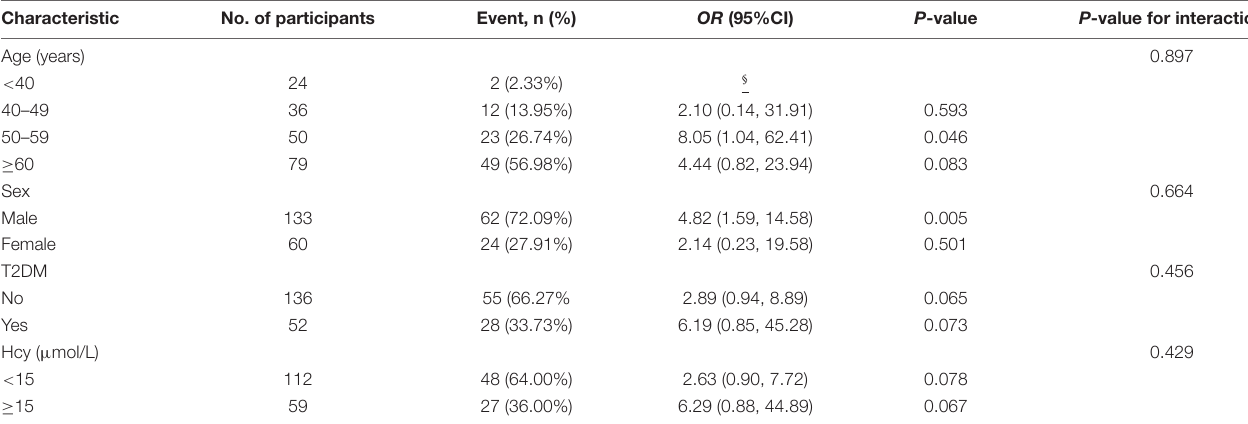
TABLE 4 | Odds ratios of hypertension on BA plaque in the prespecified and exploratory subgroups. Characteristic